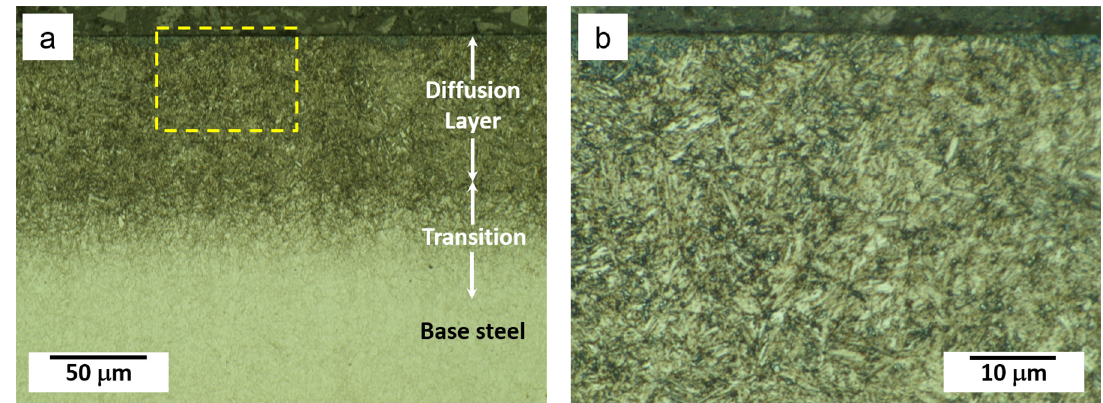
Figure 3. (a) Optical micrograph the cross-section of the pre-nitrided steel substrate. (b) Microstructure of the highlighted region in (a).